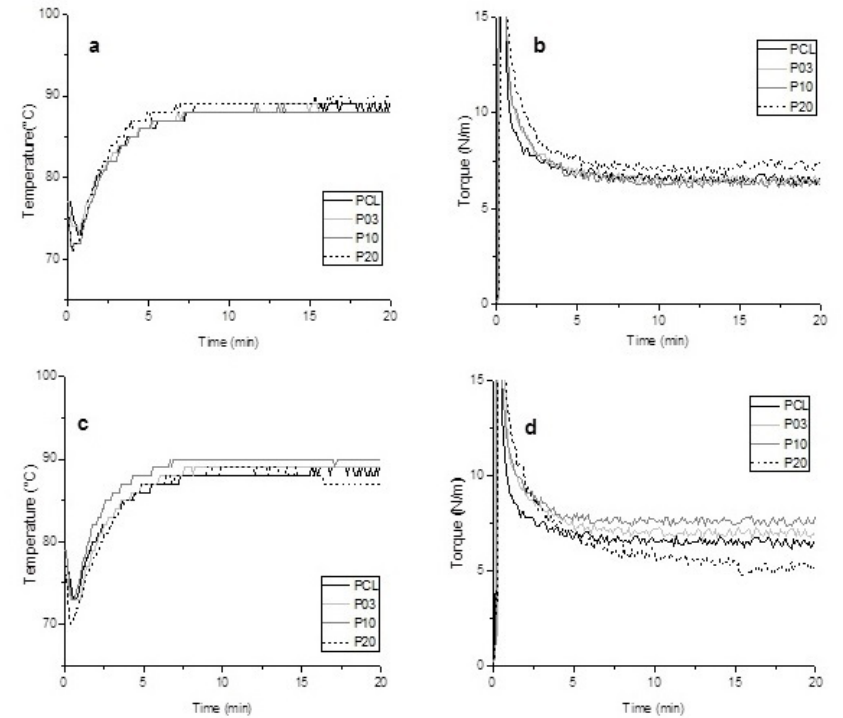
Figure 2. Temperature (left) and torque (right) versus time for PCL/MMT (a) and (b), and for PCL/OMMT (c) and (d), respectively, at several clay content as